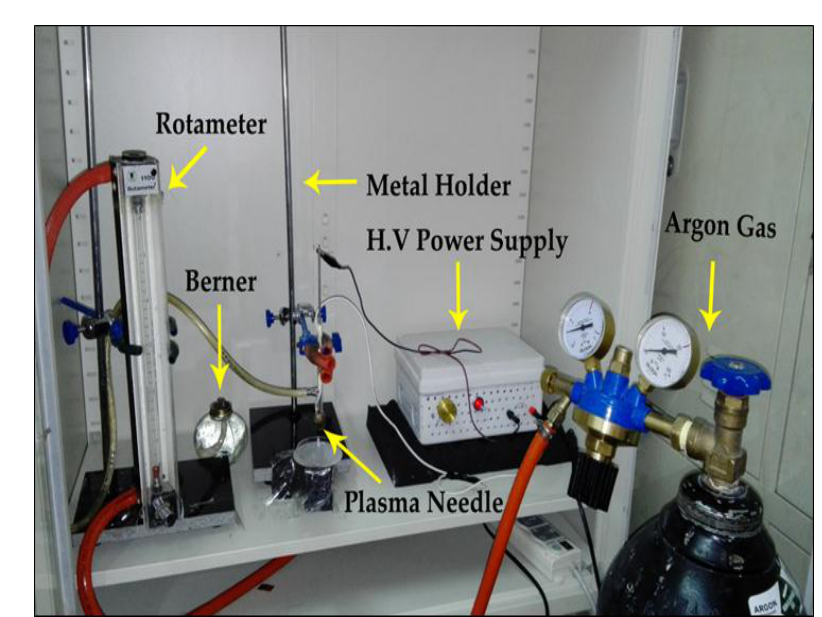
Fig.2: Image of non-thermal plasma needle